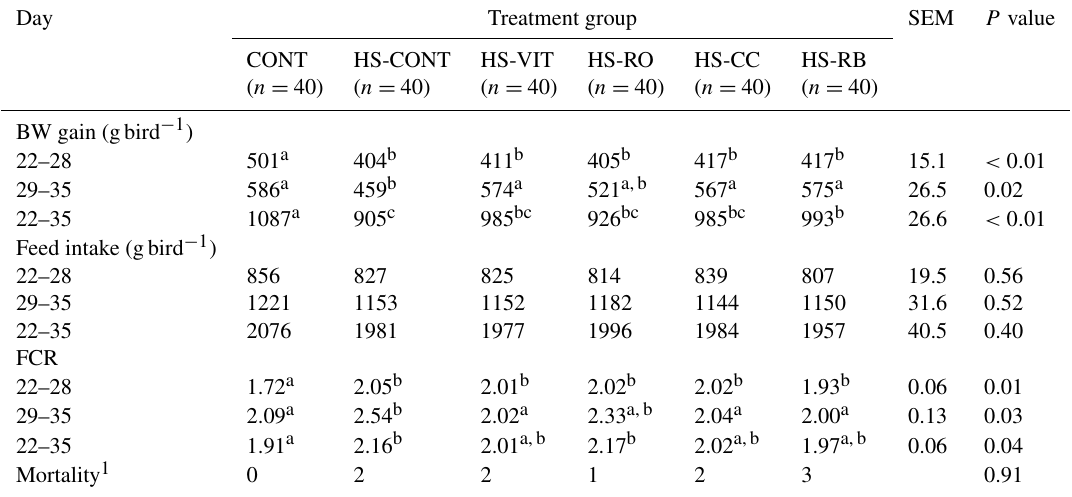
Table 3. Effect of dietary supplementation on BW gain, feed intake, FCR and mortality of broilers reared under normal or HS conditions. Day